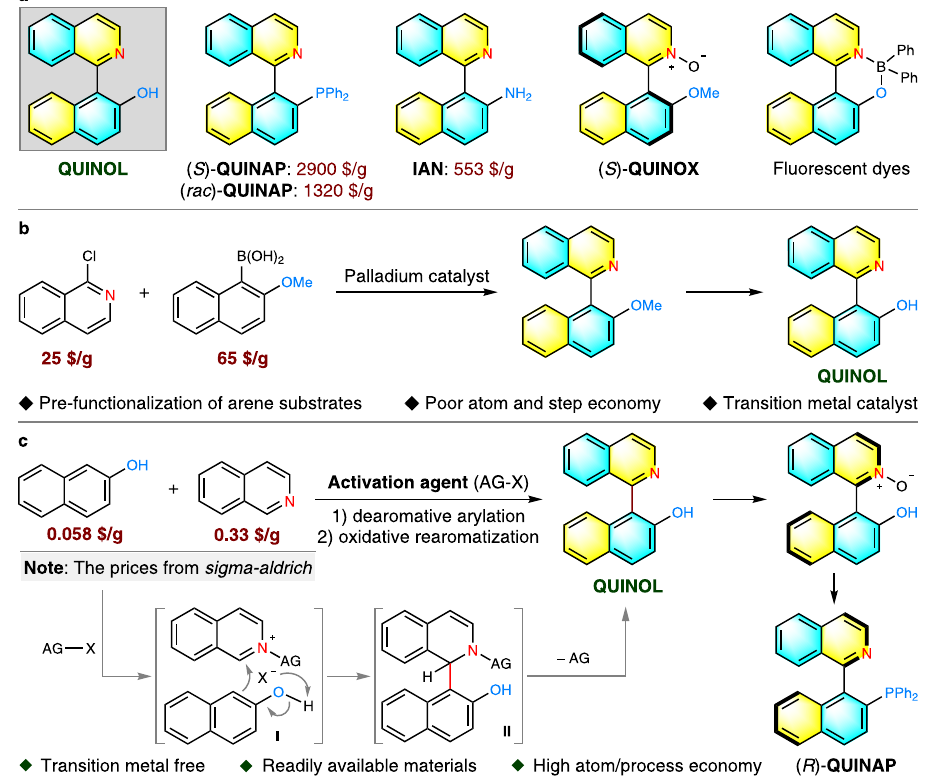
Fig. 1 The signi fi cance of QUINOL and its synthetic approaches. a QUINOL and representative biaryl isoquinoline structures. b Current strategy: transition-metal-catalyzed cross-coupling. c Our strategy: metal-free oxidative